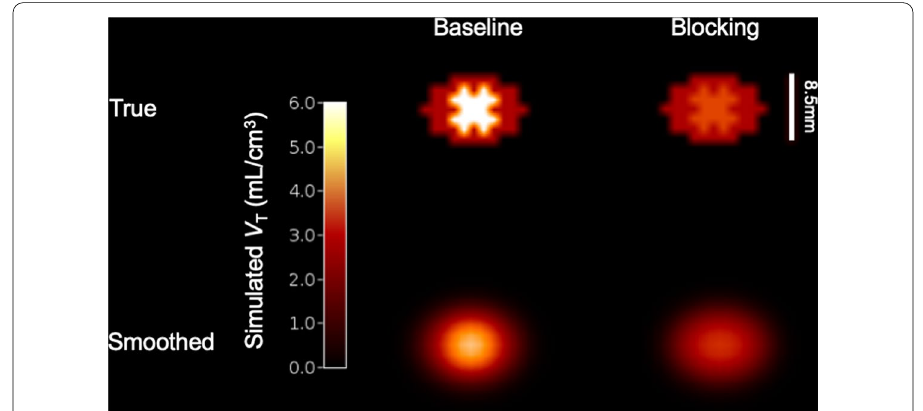
Fig. 1 Simulated Spinal Cord images for baseline and blocking conditions. Scale bar